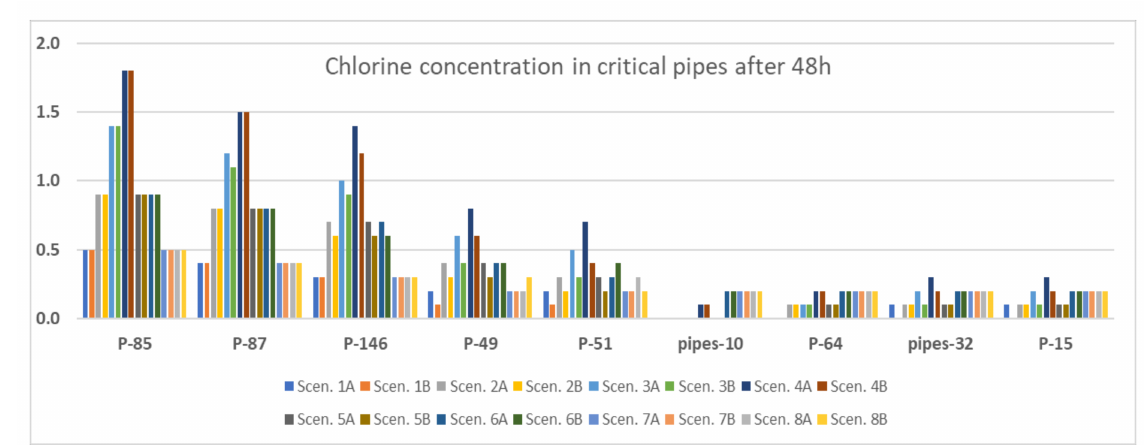
Figure 7. Residual chlorine concentration (mg/L) in critical pipes after 48 h for all